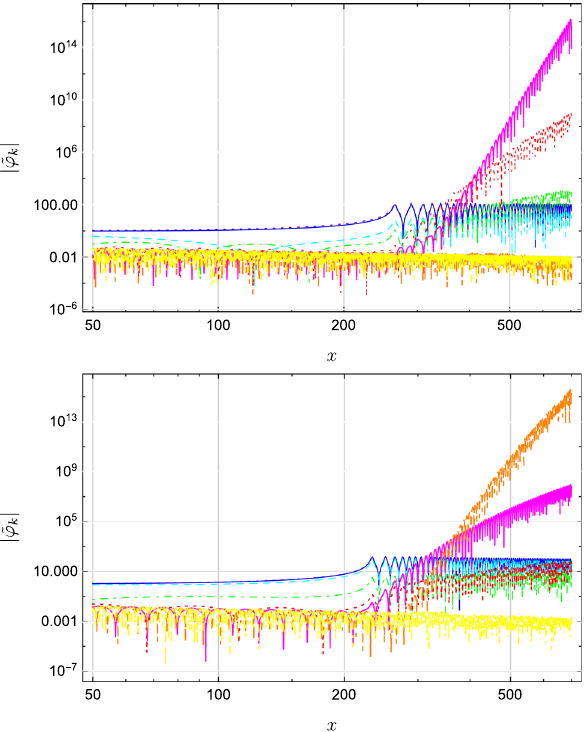
Fig. 4 These plots show the time evolutions of ˜ ϕ k during RD (up) and MD (bottom) for different wavenumbers ˜ k : ˜ k = 10 − 1 (purple, dotted), ˜ k = 10 − 1 / 2 (blue), ˜ k = 1 (light blue, dashed), ˜ k = 10 1 / 2 (green, dotdashed), ˜ k = 10 (red,thick-dotted), ˜ k = 10 3 / 2 (magenta,thick), ˜ k = 10 2 (orange, thick-dashed), and ˜ k = 10 5 / 2 (yellow, thick-dotdashed). Here, we choose c = 0. The parametric resonance instability is slightly more efficient in RD than in MD, since the comic expansion is slower